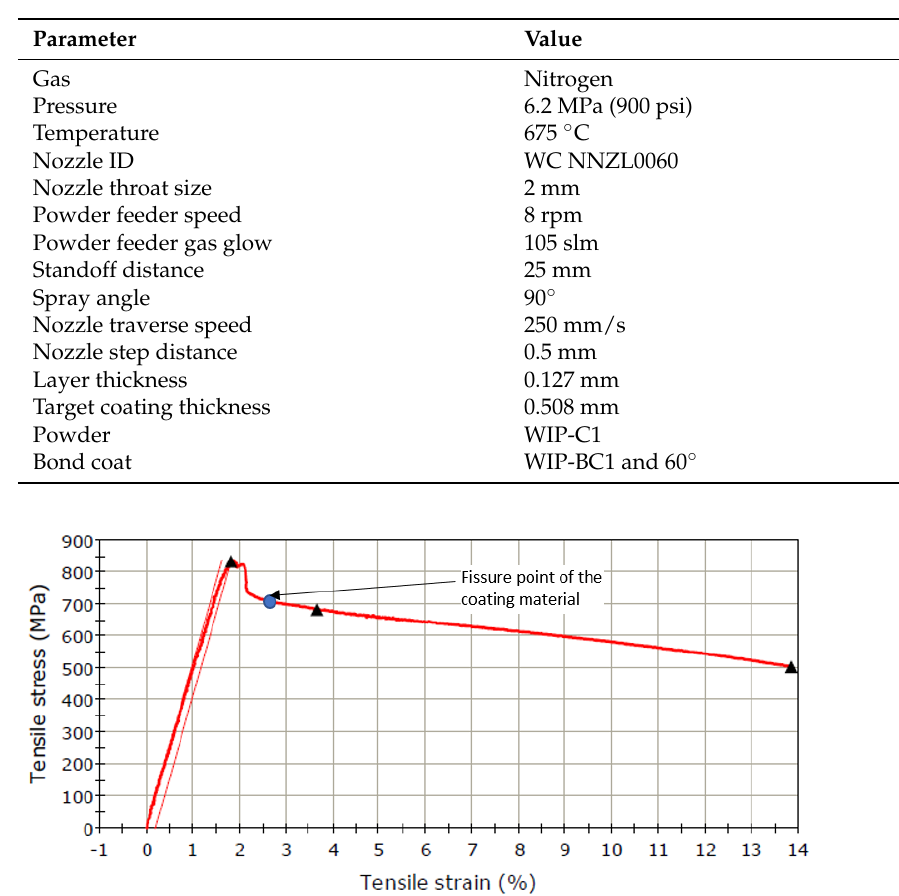
Figure 2. ( a ) The shape and dimensions of the sample (in mm). ( b ) Coated sample. ( c ) Attaching the sample to the testing machine. Table 1. Cold spray deposition parameters used to prepare the fatigue specimens.